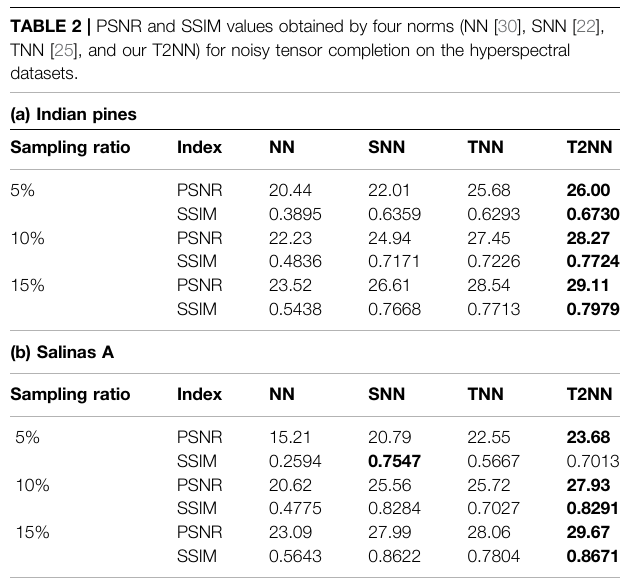
The highest PSNS/SSIM are highlighted in